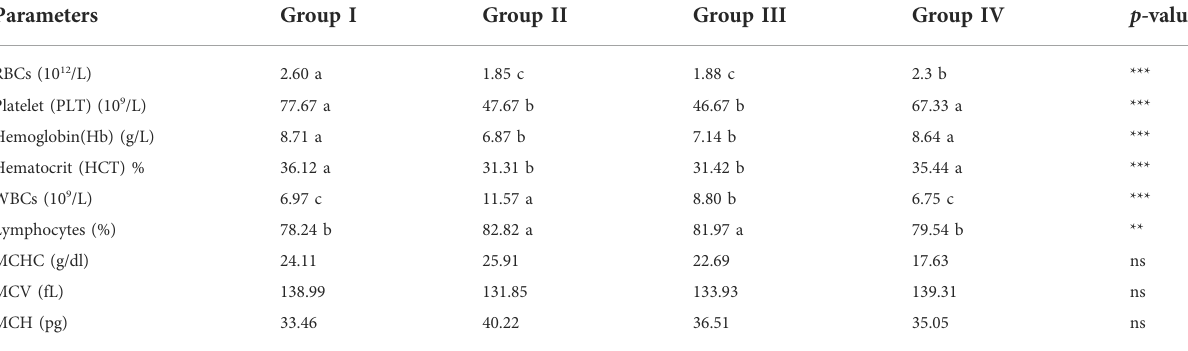
TABLE 1 Hematological parameters and blood indices values of control and experimental rat.